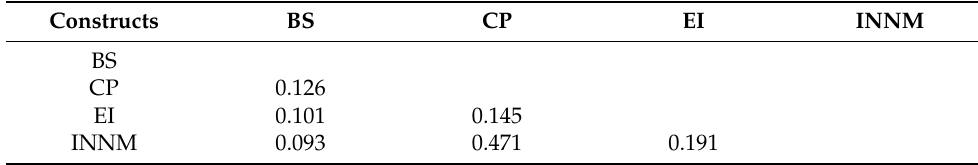
Table 3. Discriminant validity of the model (HTMT).